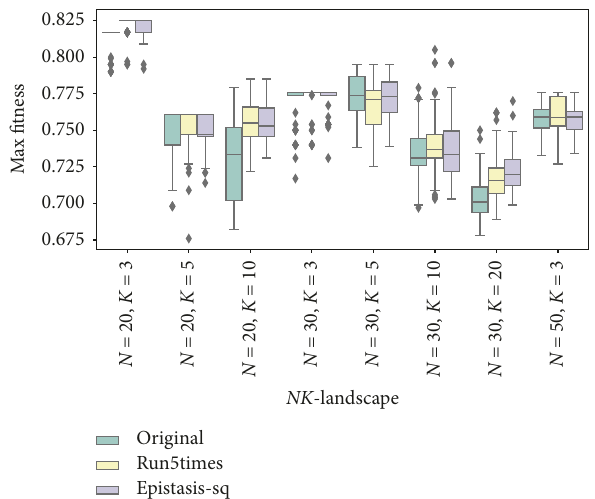
Figure 4: A box plot of each of the best solutions obtained by conducting the GA experiment 100 times on an instance of the 𝑁𝐾 - landscape